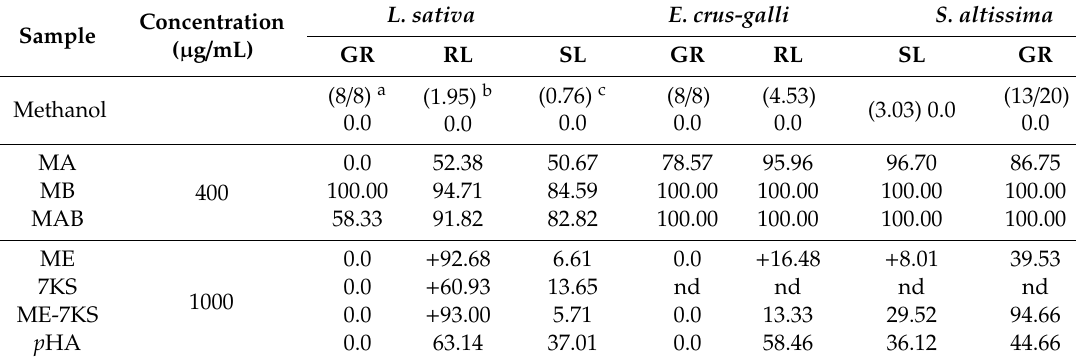
Table 3. Comparative allelopathic e ff ects (%) of isolated compounds on growth of tested plants. Sample